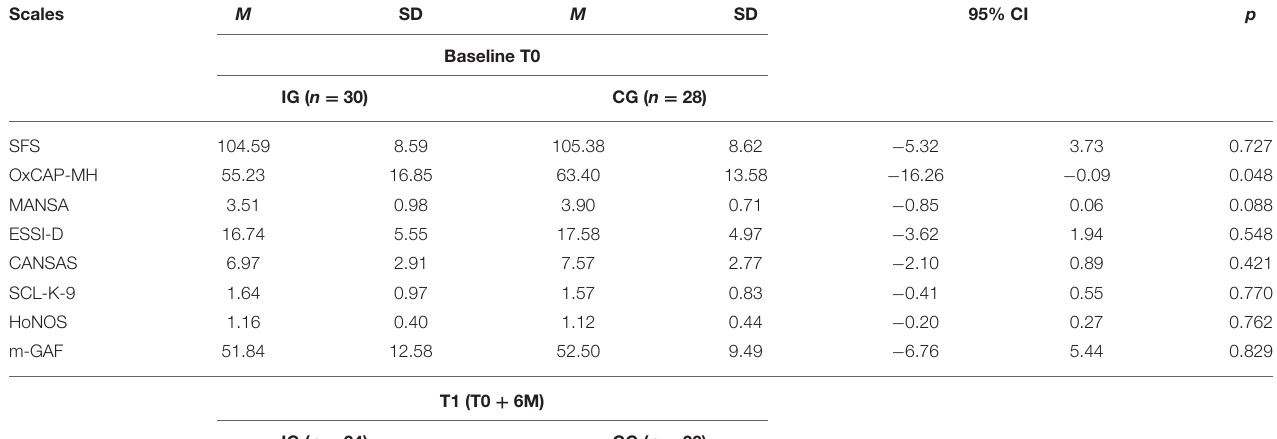
TABLE 3 | Differences in social inclusion, capabilities, quality of life, social support, needs, mental state and functioning between the intervention group (IG) and the control group (CG) at baseline, T1 and T2. Scales